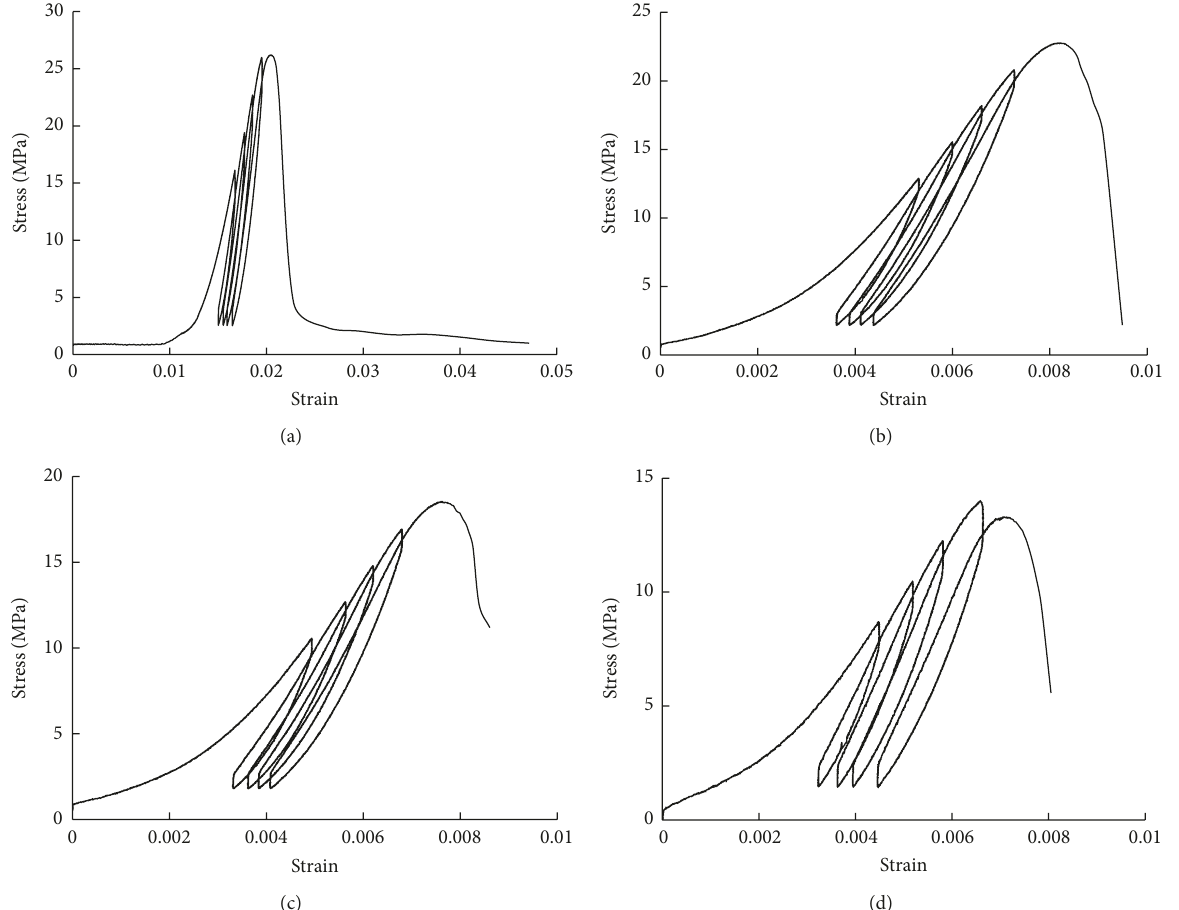
Figure 2: Stress-strain curves of the samples with different water contents under loading and unloading conditions: (a) 0%, (b) 25%, (c) 50%, and (d)